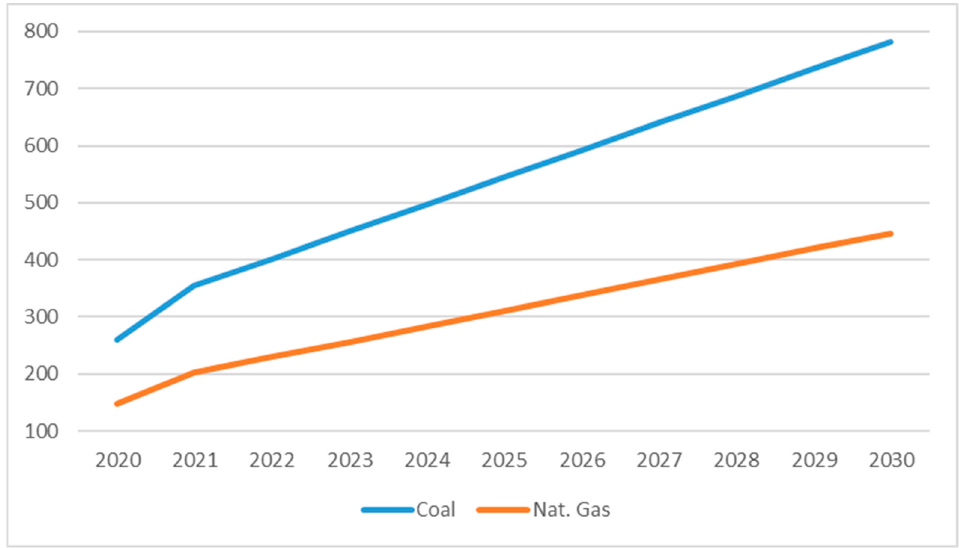
Figure 9. The projected avoided CO 2 emissions as the result of solar energy generation by house- holds and energy cooperatives,